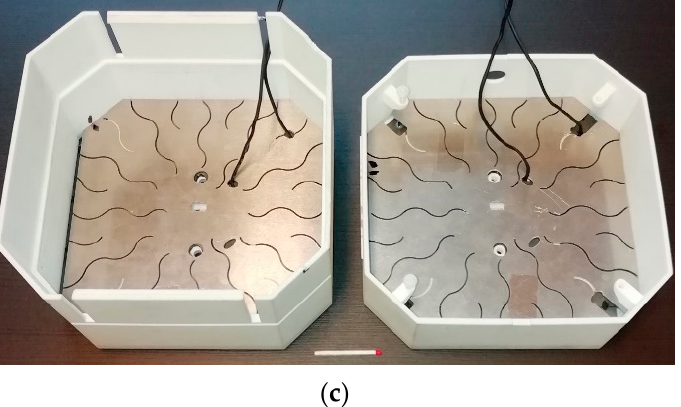
Figure 5. Coils of MCR circuit: ( a ) primary coil, ( b ), coils with magnetic shields, ( c ) coils with magnetic shields and aluminum plates.